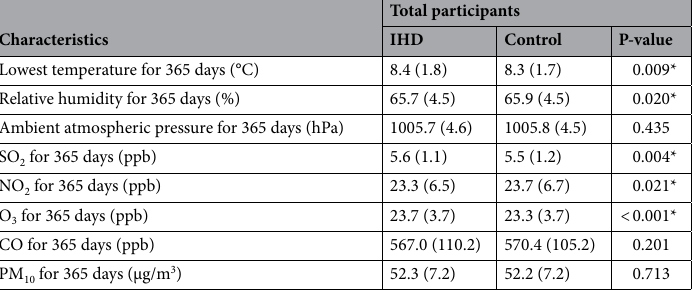
Table 1. General characteristics of the participants. IHD ischemic heart disease, BMI body mass index (kg/ m 2 ), ppb parts per billion, ppm part per million (= 1000 ppb), SD standard deviation. *Chi-square test or independent t-test. Significance at P < 0.05.